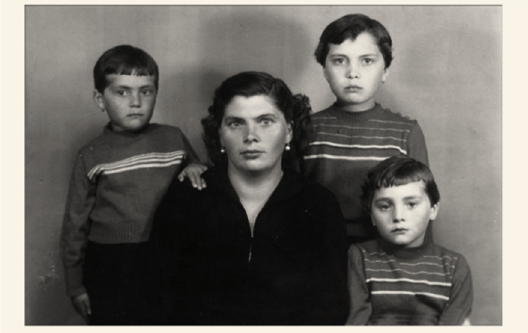
Figure 2. Virtudes (e misterioso) Xesús Fraga (2020, p. 300). Reprinted with permission from Xesús